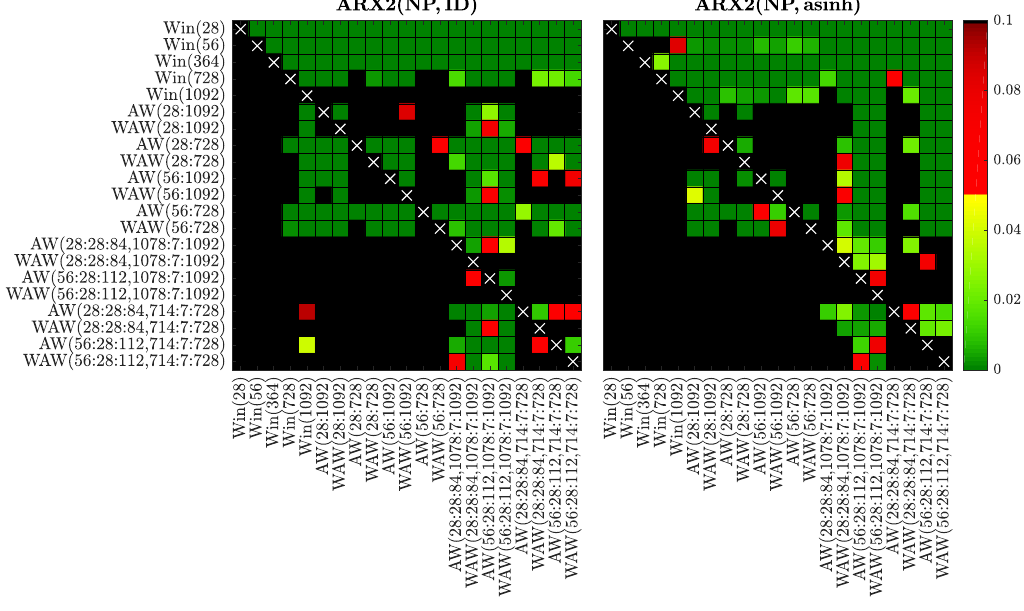
Figure 9. Results of the CPA test for selected window sets and the ARX2 model fitted to raw ( left ) or asinh -transformed ( right ) Nord Pool data. We use a heat map to indicate the range of the p -values—the closer they are to zero ( → dark green) the more significant is the difference between the forecasts of a set on the X -axis (better) and the forecasts of a set on the Y -axis